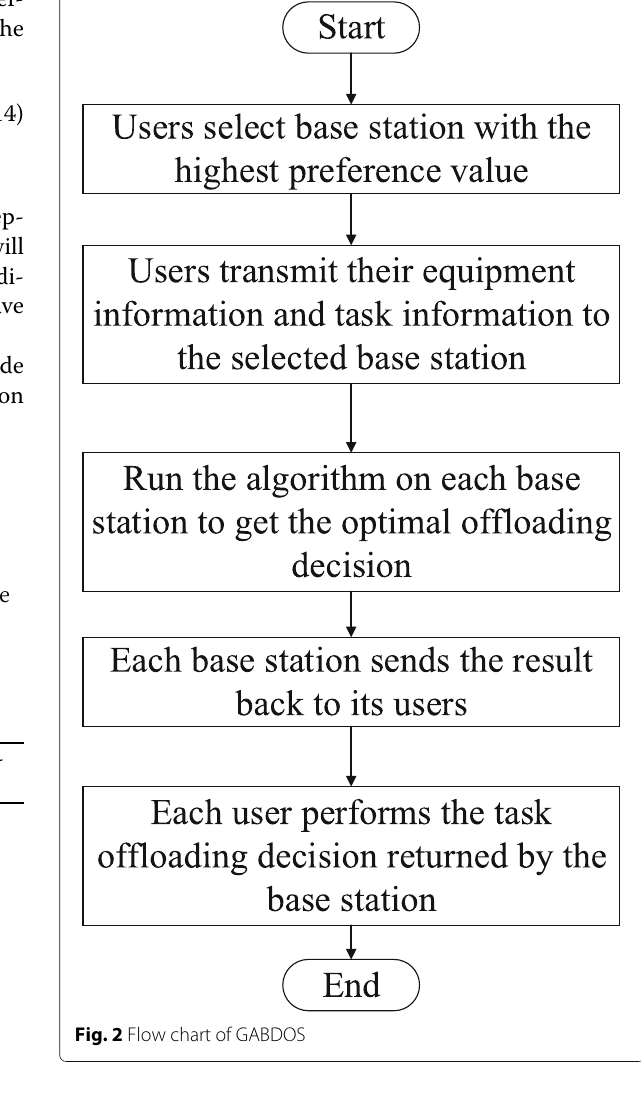
Fig. 2 Flow chart of